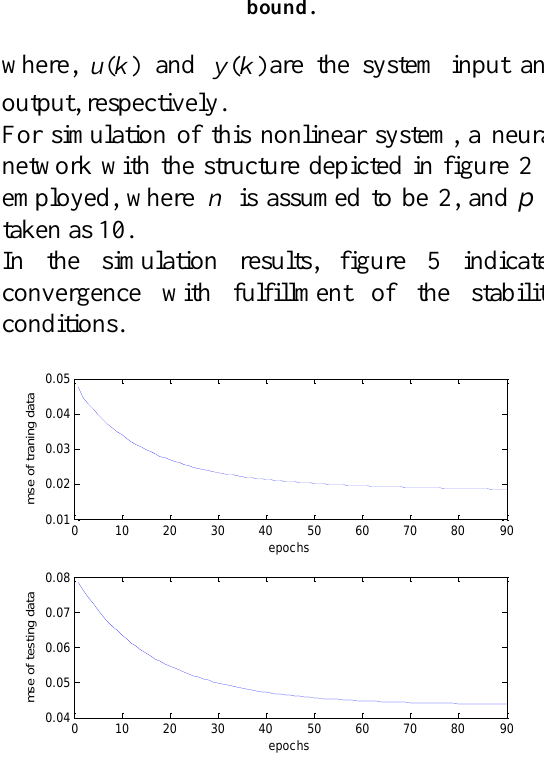
Figure 5. Learning rate is smaller than the upper limit